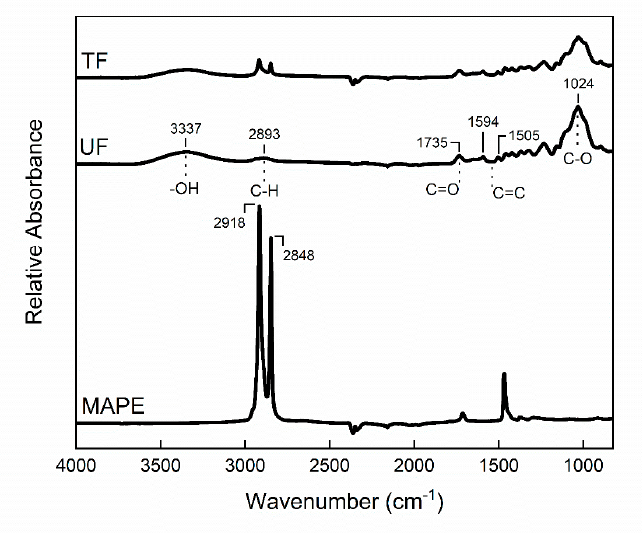
Figure 3. Fourier transform infrared (FTIR) spectra for maleated polyethylene (MAPE), as well as untreated (UF) and treated (TF) maple fibers.